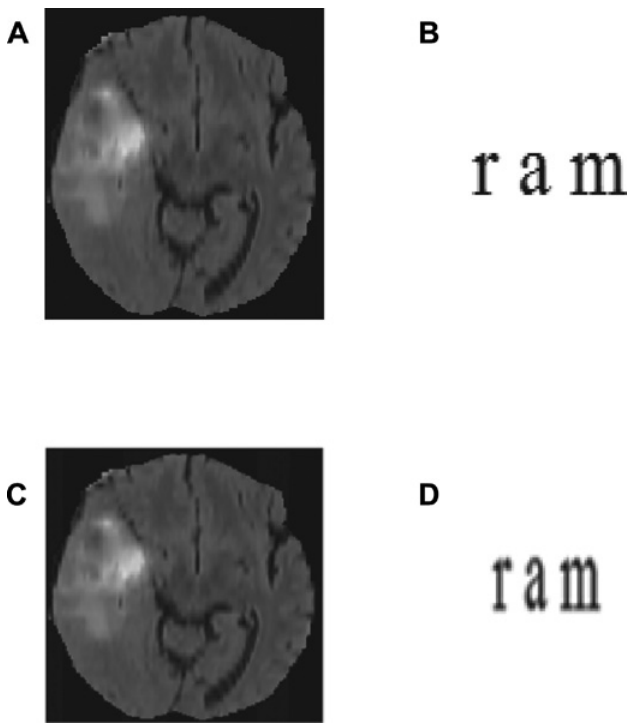
Figure 3: Intermediate Results of Image